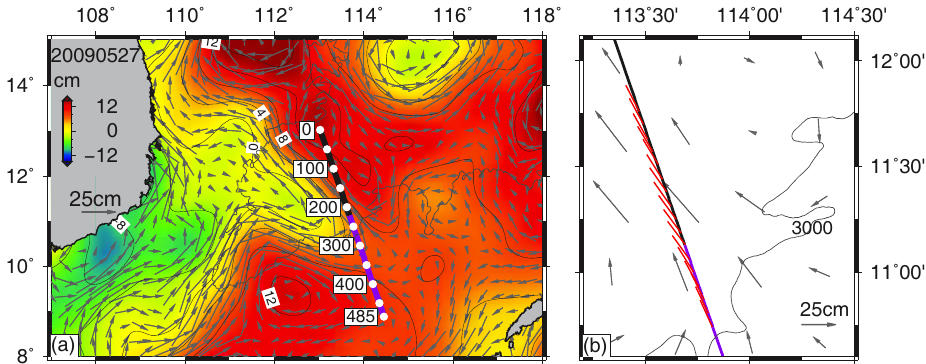
Fig. 4. (a) The SLA and the corresponding surface geostrophic currents on 27 May 2009. The seismic line and the 3000m isobath are superimposed for reference. (b) Streamer feathering (red bars) due to the strong NW current (grey arrows) around the line